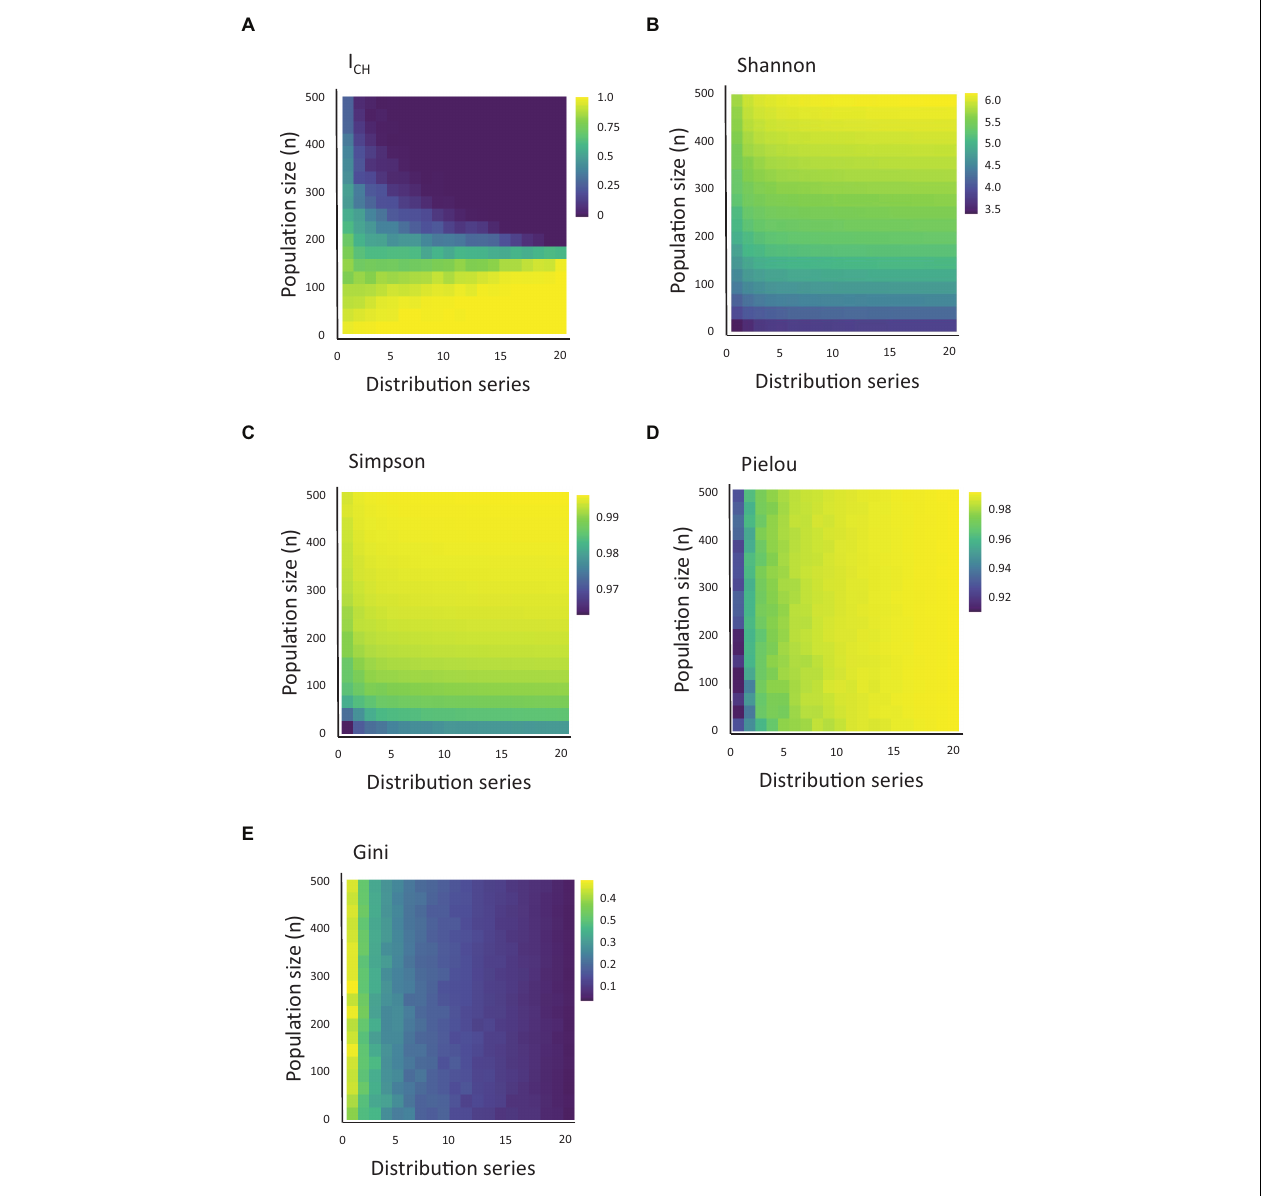
FIGURE 2 | Quantification of CH using measures of population diversity. (A) Heatmap of the value of I CH , depending on the clonal population size and population skewing, simulated using the series of 20 distributions shown in Figure 1 (starting from the lowest alpha and highest beta) and using a threshold of 0.005. (B–E) The same as Figure 1A, measured for Shannon, Simpson, Pielou and Gini